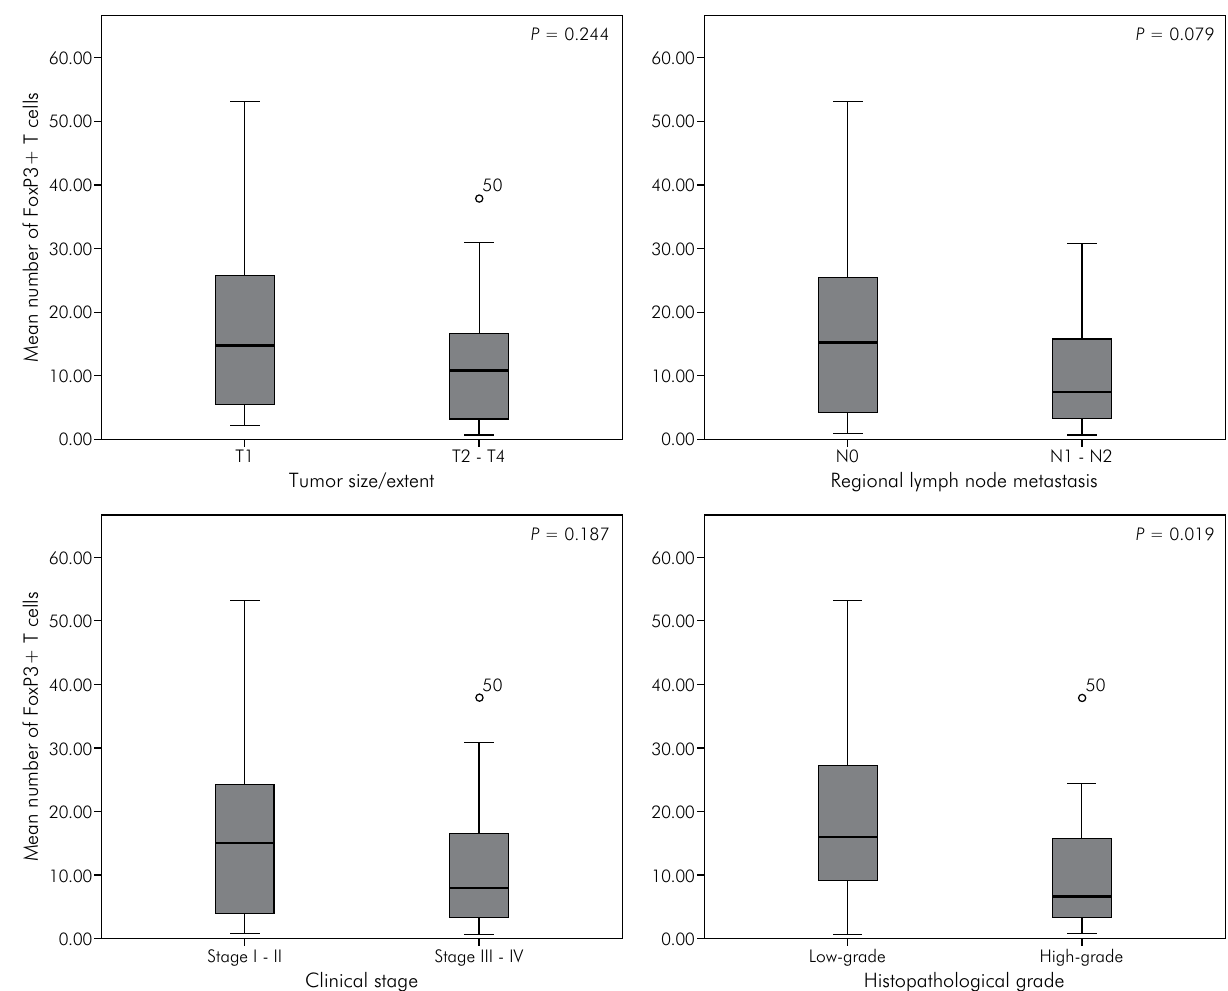
Figure 2. Box plot charts illustrating the number of FoxP3+ lymphocytes in LLSCCs according to tumor size, regional lymph node metastasis, clinical stage, and histopathological grade of